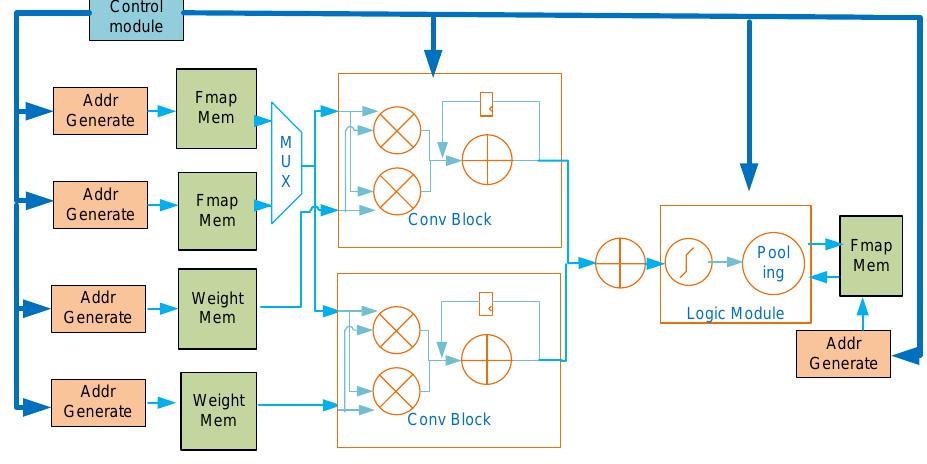
Figure 5. Design structure in a Convolution